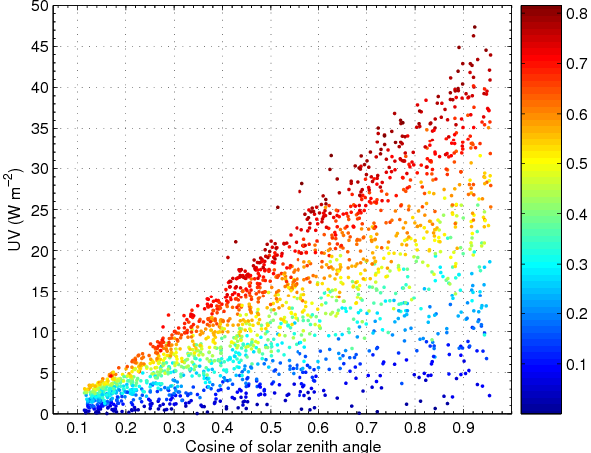
Fig. 7. UV radiation versus the cosine of the solar zenith angle. Figure 7. UV radiation versus the cosine of the solar zenith angle. Data points for Data points for different clearness index ( Kt ) are represented by dif- ferent colors. The values of UV for narrow ranges of the clearness different clearness index (Kt) are represented by different colors. The values of UV index increase with the cosine of the solar zenith for narrow ranges of clearness index linearly increase with the cosine of the solar zenith angle.